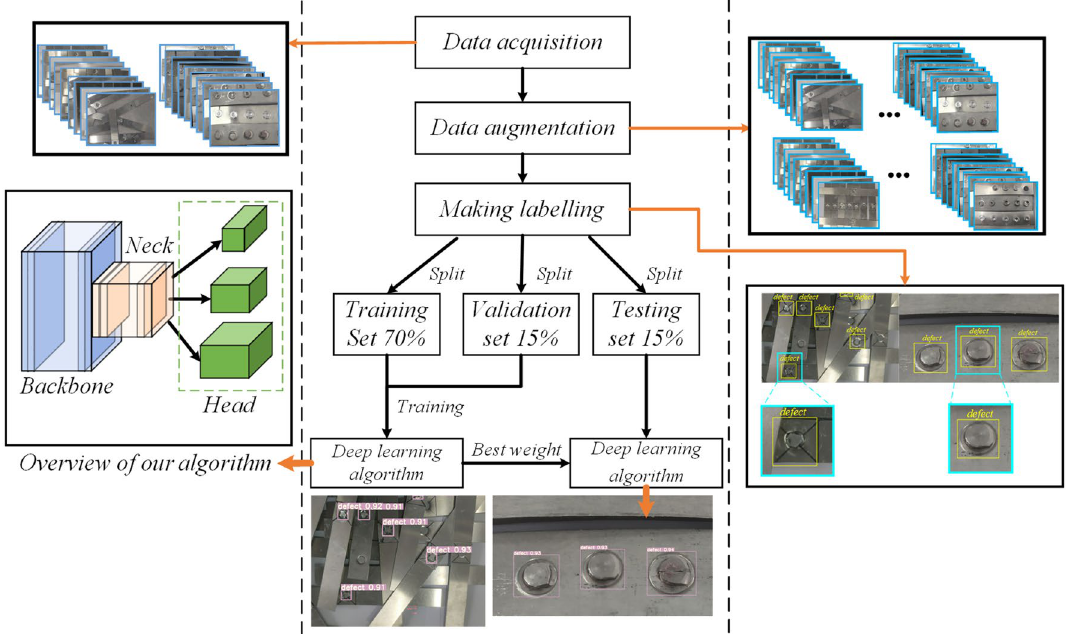
Figure 4. Convolutional neural network realizes SPR quality